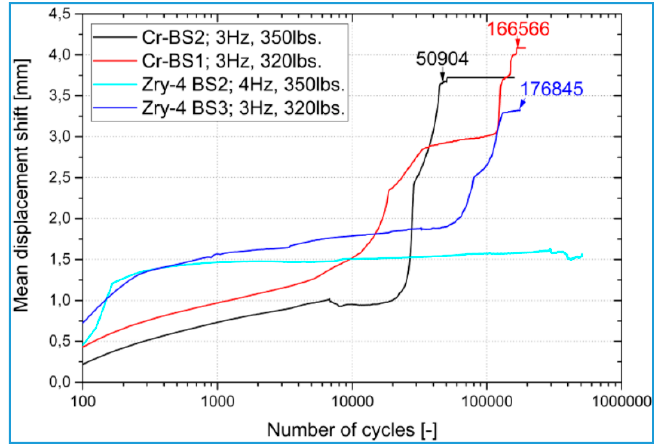
Figure 1. Comparison of fatigue behavior of Cr CS-coated Zr-4 sheet and uncoated samples. Reproduced from the work in [12] with copyright permission from the American Nuclear Society (ANS) and the author.